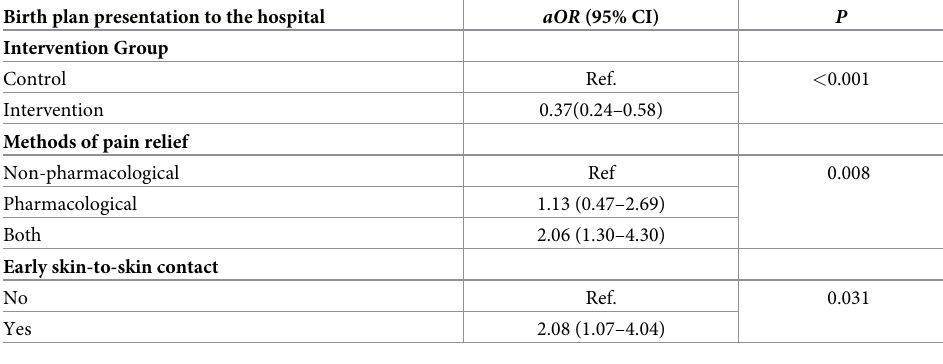
Table 8. Multinomial analysis of the birth plan presentation to the hospital with obstetrics results and interven- tion group. Stepwise logistic